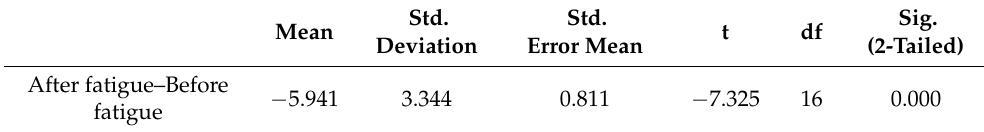
Table 9. Paired samples t -test results of heart rate.